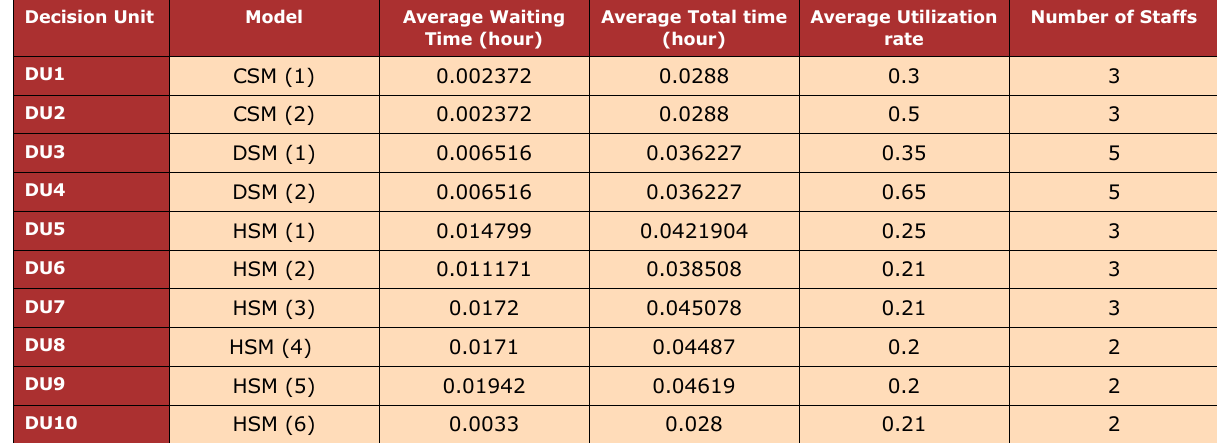
Table 6. Simulation outputs for the setting with low